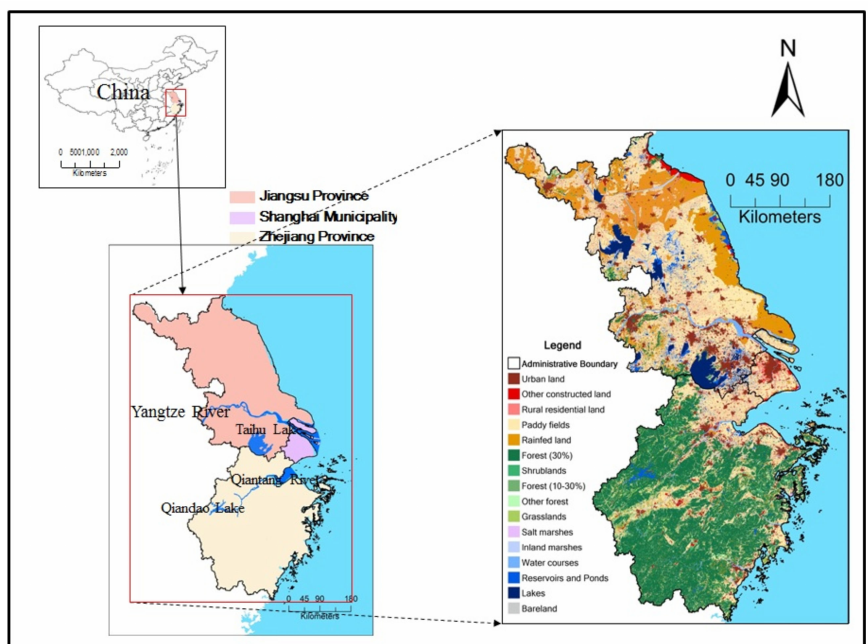
Figure 2. Location of the Yangtze River Delta